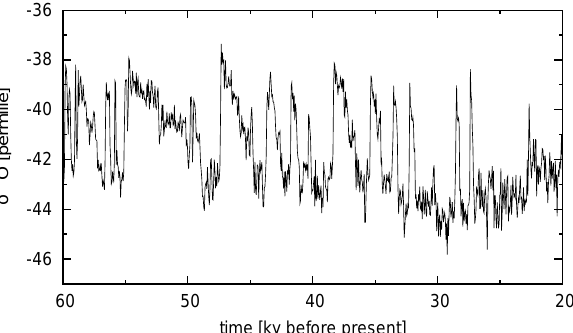
Fig. 4. Record of δ 18 O from the NGRIP ice core for the last glacial period.